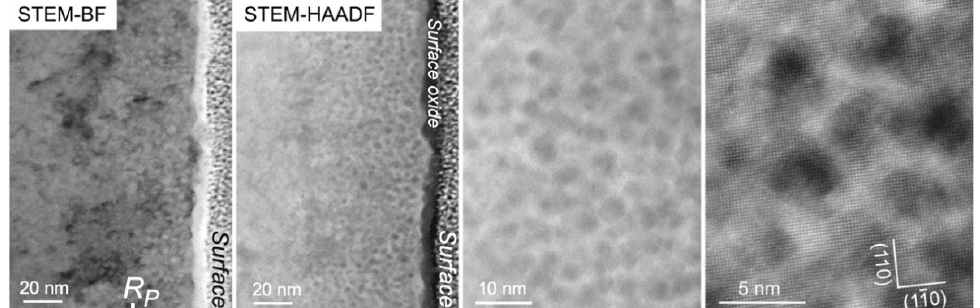
Figure 8. STEM-BF and STEM-HAADF imaging of an FeCr specimen implanted with Y → Ti → O ions and annealed at 1100 °C for two hours. The synthesized precipitates appear light on a darker background in the STEM-BF picture, and dark on a lighter background in STEM-HAADF pictures. The first two images are from the same area and are taken at the same magnification. The last picture taken at high magnification highlights the cuboidal shape of the precipitates.